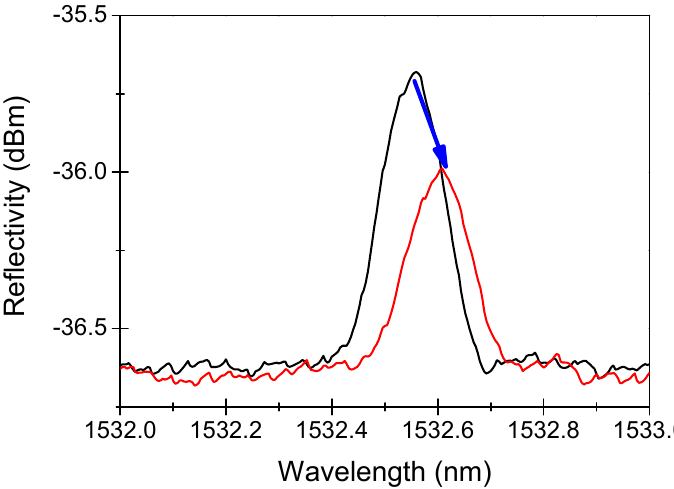
Figure 2. An example of the radiation-induced effects on a Bragg peak reflection spectrum, before